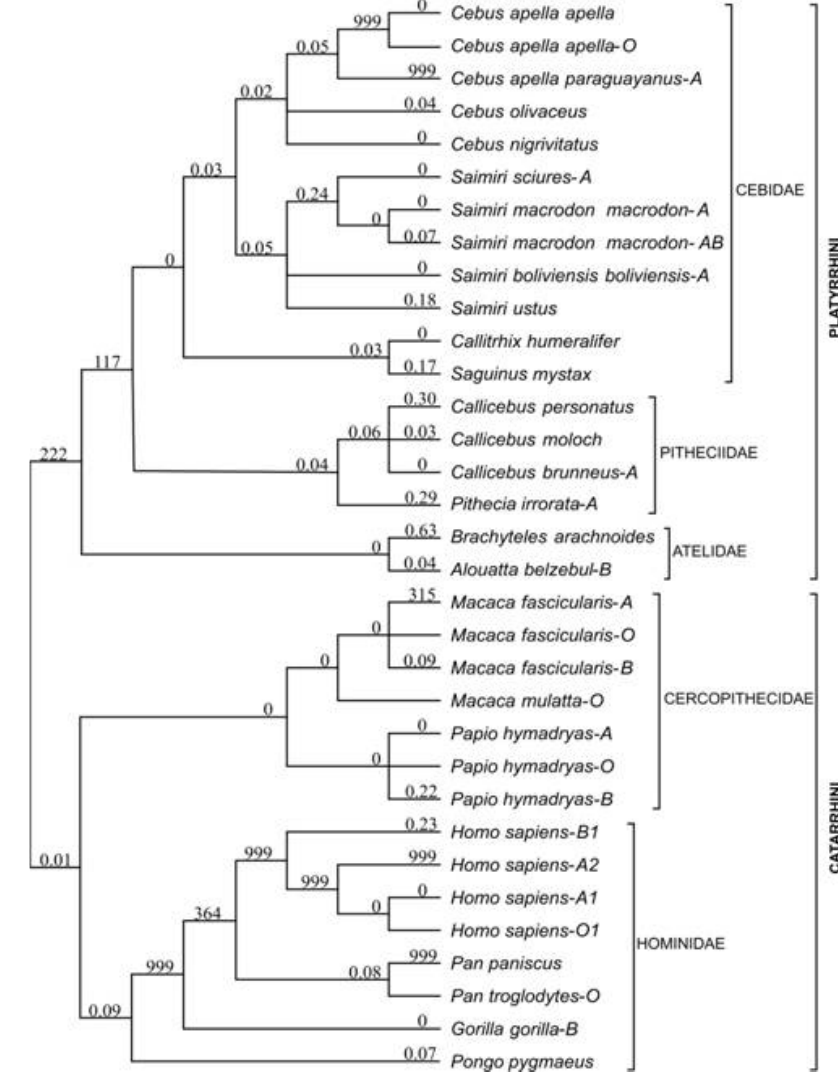
Fig. 1. Estimative of dN/dS (ω parameter) under M1 “free ratio” model measured by Codeml. Numbers of nonsynonymous and synonymous sites under this model are 488.5 and 63.5, re- spectively. It is shown species and their ABO phenotype (if known).